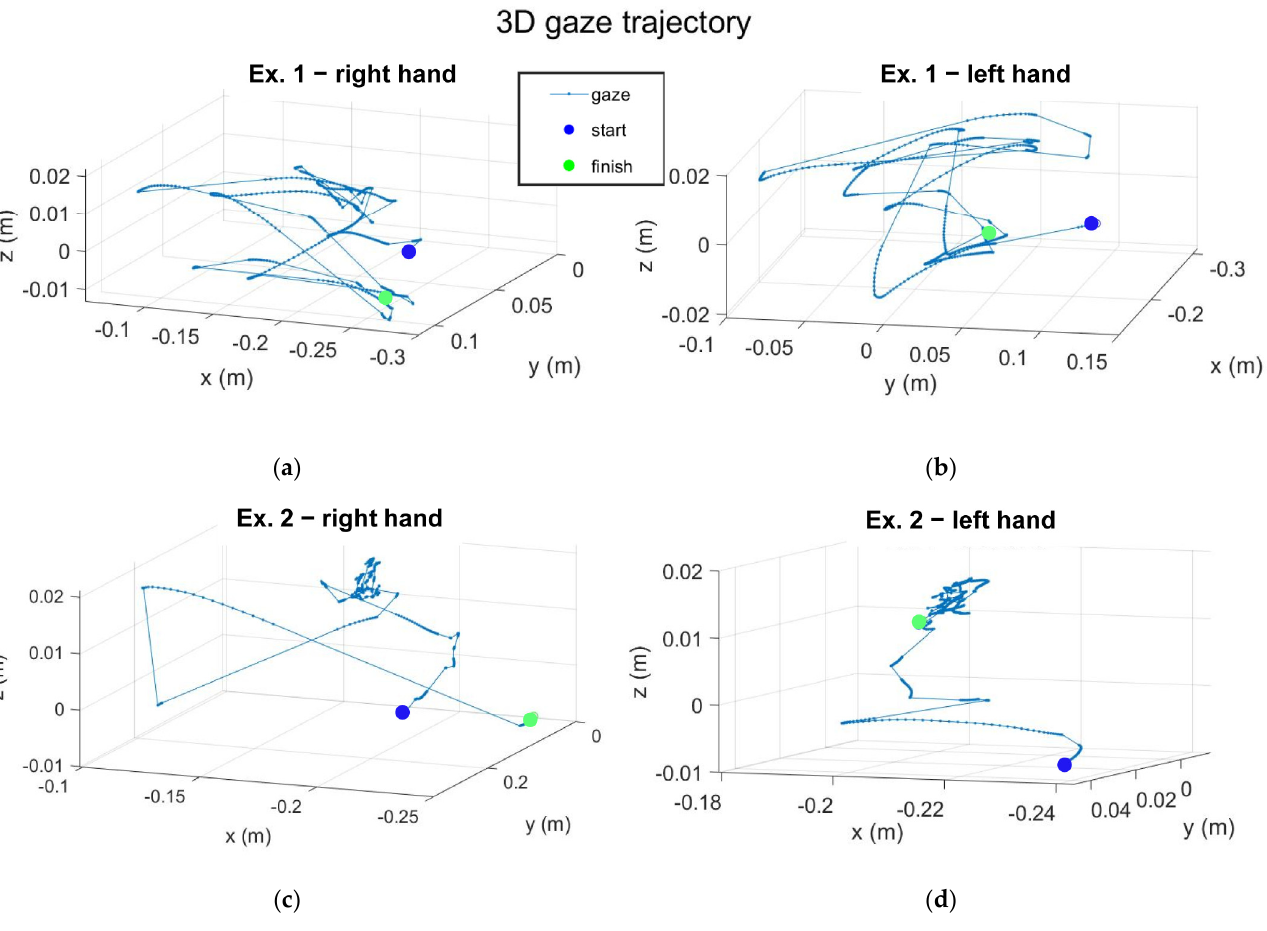
Figure 6. Graphs of the trajectories of the subject’s gaze: ( a ) trajectory during exergaming 1 performed with the right hand, ( b ) trajectory during exergaming 1 performed with the left hand, ( c ) trajectory during exergaming 2 performed with the right hand, ( d ) trajectory during exergaming 2 performed with the left hand.